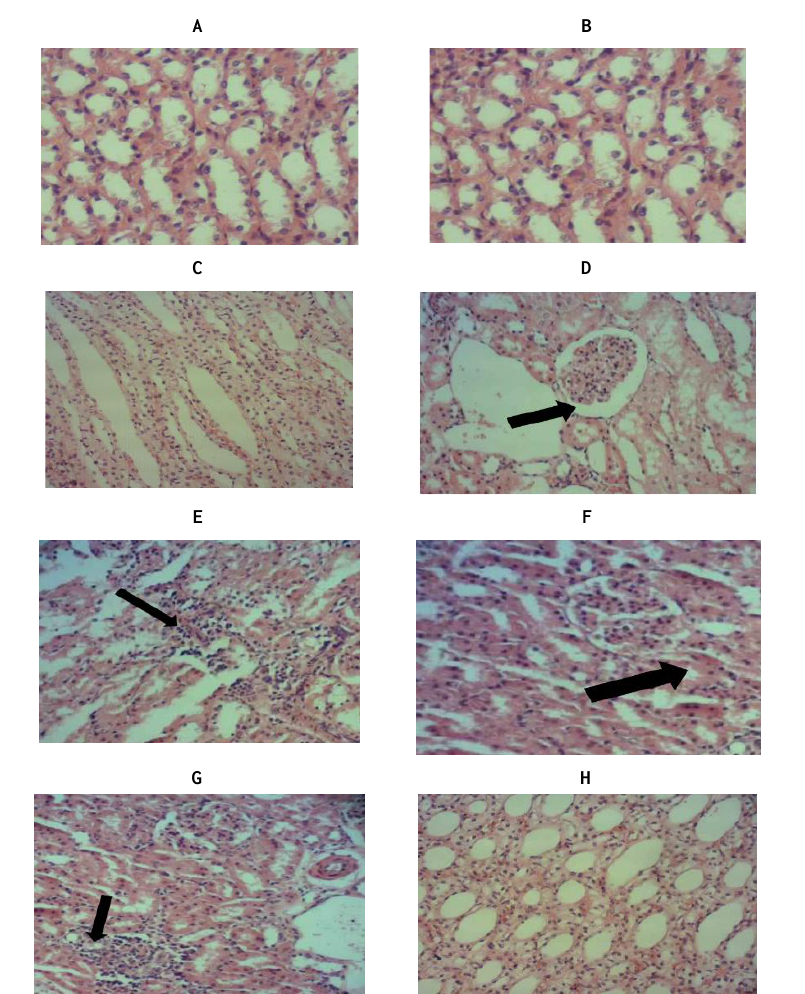
Fig. 5. Hematoxylin and eosin-stained sections of photomicrographs of kidney tissue with a magnification of 100 in different groups of animals received ZOE and